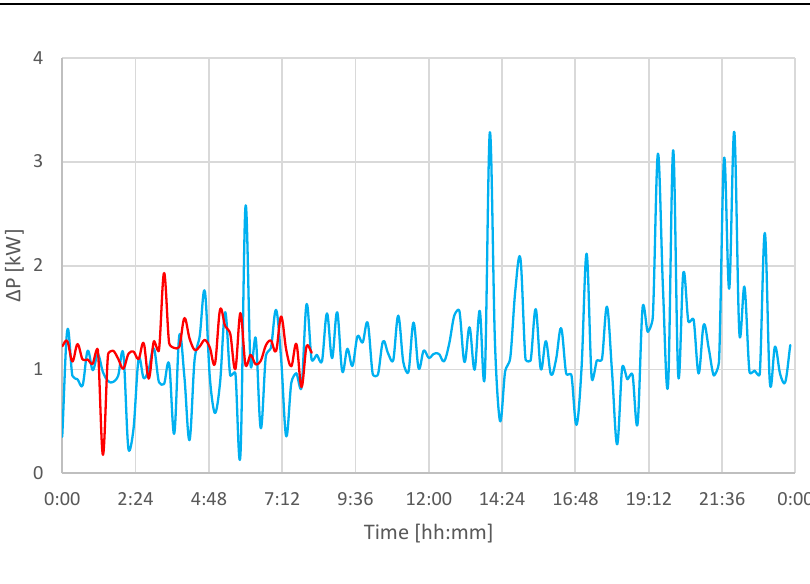
Figure 7. Daily changes of active power losses.